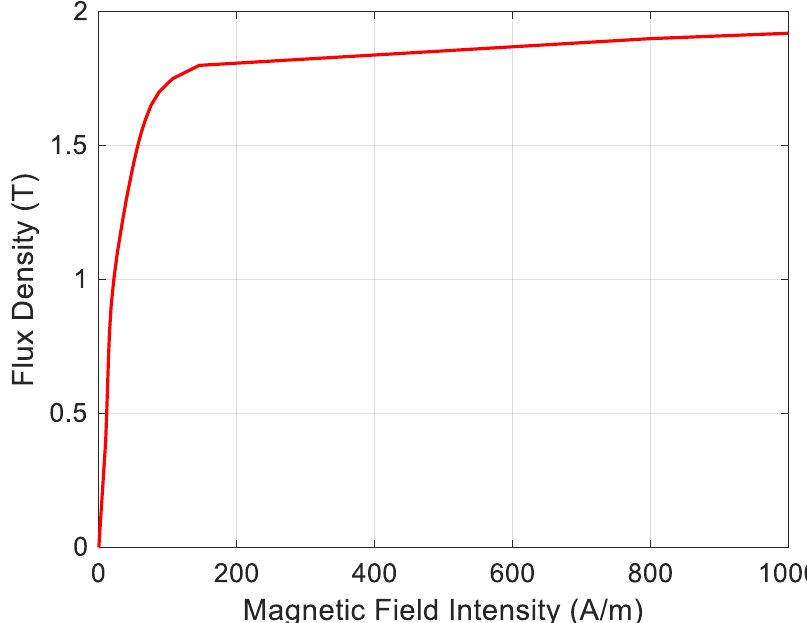
Figure 8. BH curve of material Power Core ® H 075-23L.